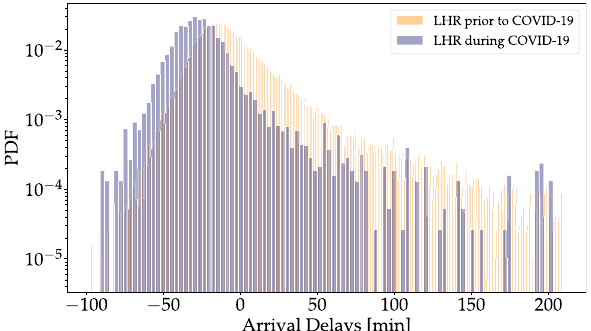
Figure 1. Flight delays follow a broad distribution with large negative and positive delays. We display LHR delay histograms prior to and during the COVID-19 pandemic, both normalized. As the COVID-19 LHR data set is significantly smaller in size, compared to the regular LHR data set, it contains many gaps, where no data were recorded. The COVID-19 data set is significantly shifted towards the left (smaller delays) as compared to the pre-pandemic